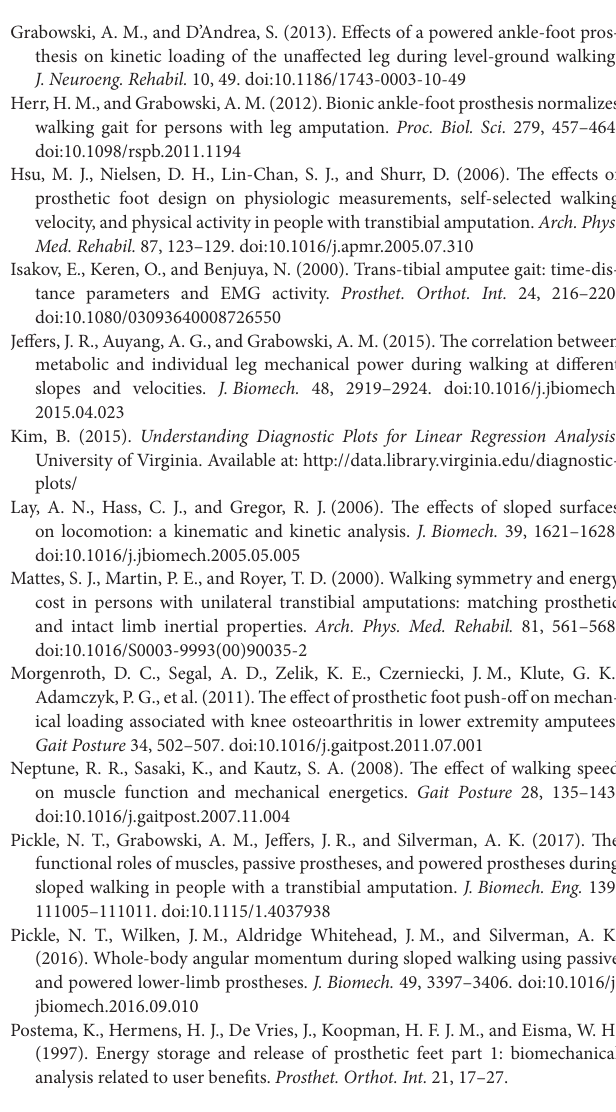
prosthesis (gray) during walking at 1.25 m/s on uphill slopes (a–c) , level ground (D) , and downhill slopes (e–g) . Solid lines represent subjects’ UL data and dashed lines represent subjects’ AL data. This figure is for visualization of joint power over a stride, which we integrated to calculate joint work. FigUre s2 | Affected leg (AL) prosthetic and unaffected leg (UL) ankle power (ensemble average) during the stance phase for subjects using a BiOM powered prosthesis (black) and their own passive-elastic energy storage and return (ESAR) prosthesis (gray) during walking at 1.25 m/s on uphill slopes (a–c) , level ground (D) , and downhill slopes (e–g) . Solid lines represent subjects’ UL data and dashed lines represent subjects’ AL data. This figure is for visualization of joint power over a stride, which we integrated to calculate joint work. FigUre s3 | Affected leg (AL) and unaffected leg (UL) knee power during the stance phase (ensemble average) for subjects using a BiOM powered prosthesis (black) and their own passive-elastic energy storage and return (ESAR) prosthesis (gray) during walking at 1.25 m/s on uphill slopes (a–c) , level ground (D) , and downhill slopes (e–g) . Solid lines represent subjects’ UL data and dashed lines represent subjects’ AL data. This figure is for visualization of joint power over a stride, which we integrated to calculate joint